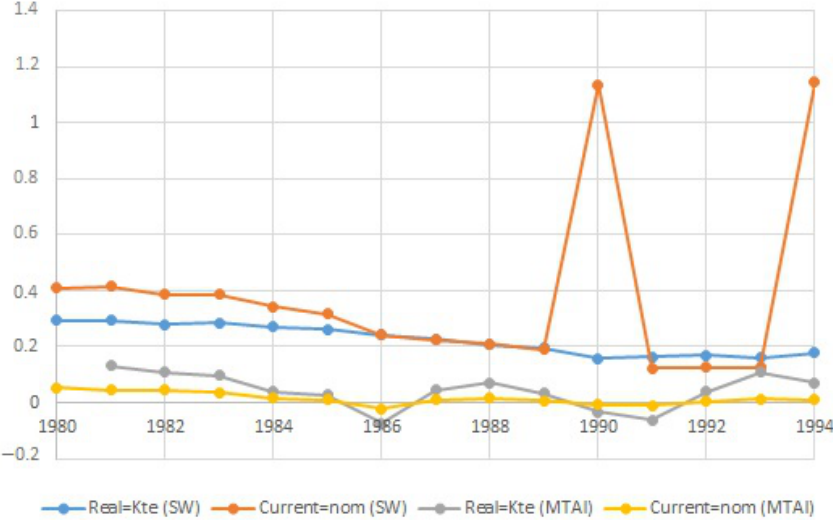
Figure 2. Specific weight of maritime transport: contribution to inflation . Source: own elaboration based on the data in Table 7 .